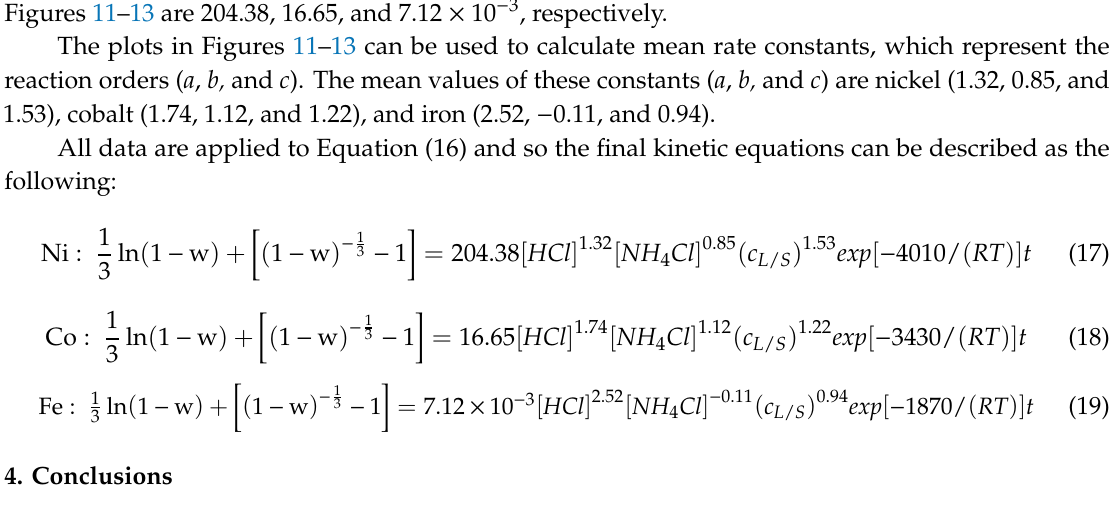
− ln c L / S of Ni, Co, and